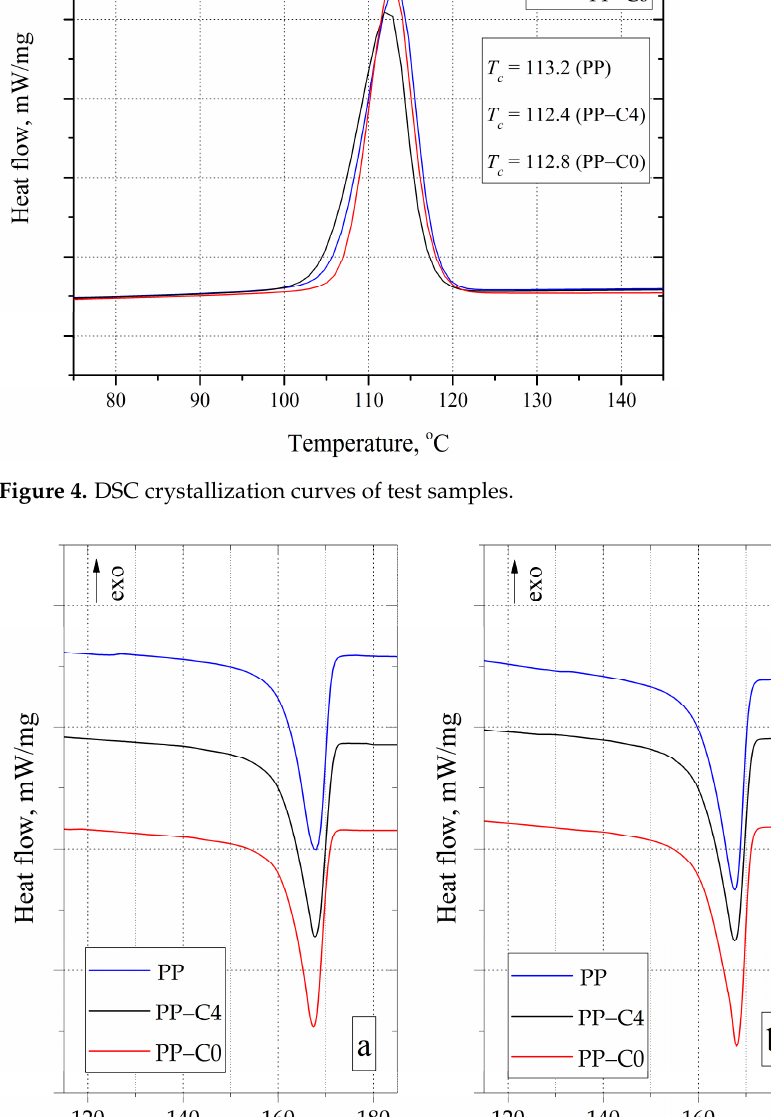
Figure 4. DSC crystallization curves of test samples .